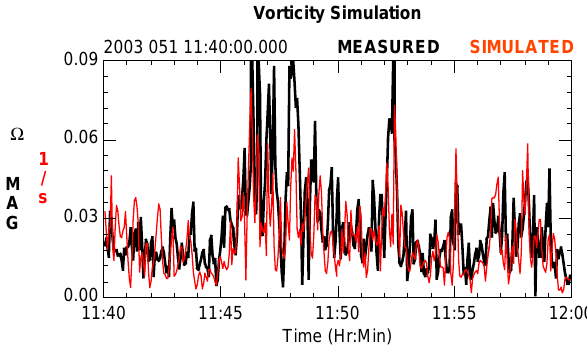
Fig. 13. Same format plot as shown in Fig. 11 but restricted to the time range shown in Fig.